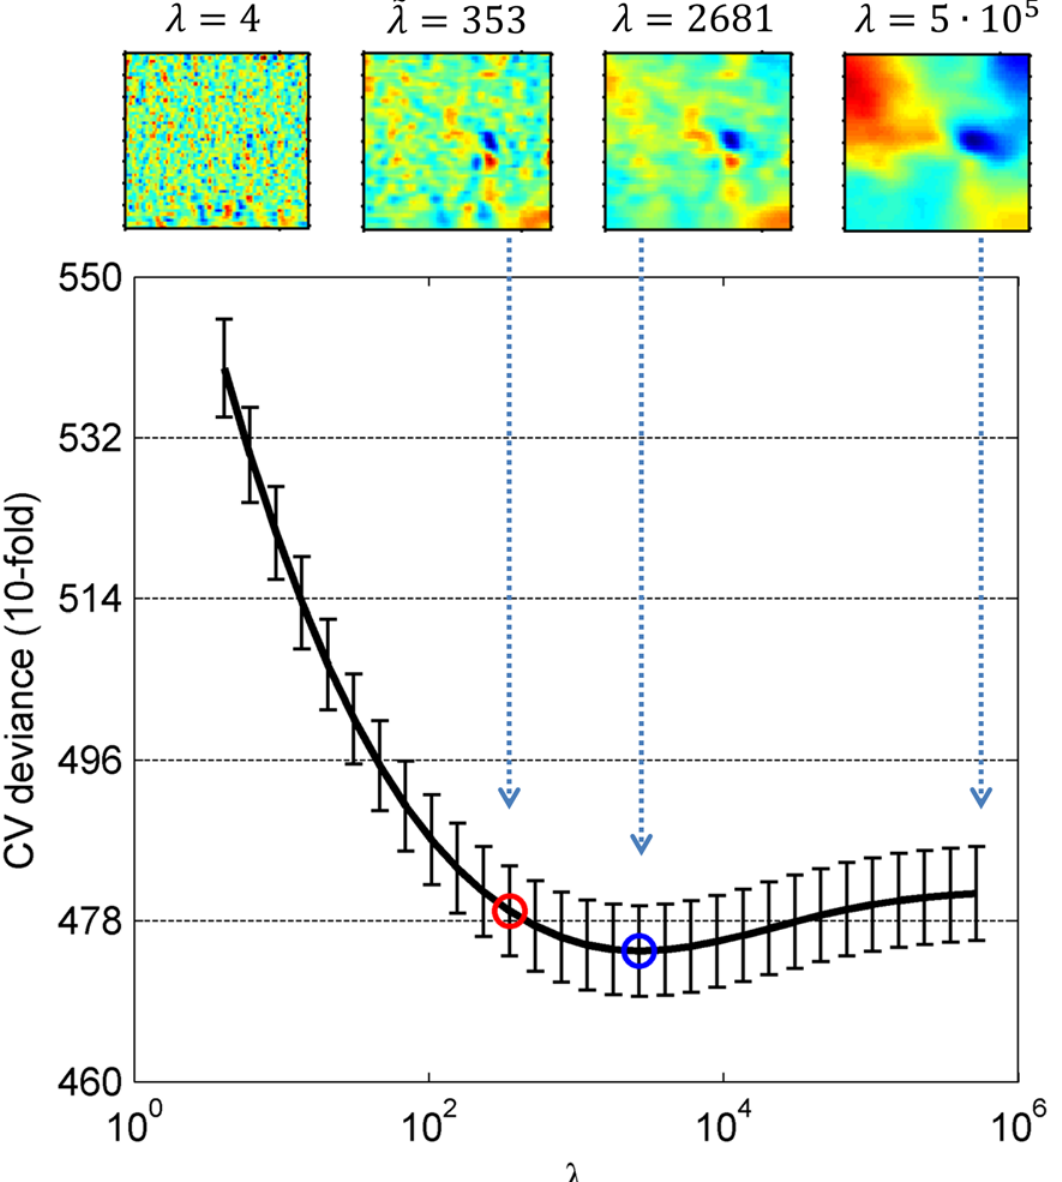
Fig 2. CV deviance of the penalized GLM for participant #17 as a function of regularization parameter λ . The minimum value of the CVD function is indicated with a blue circle, and the optimal lambda l ~ is indicated with a red circle. Examples of ACIs obtained with different values for this participant are shown below.